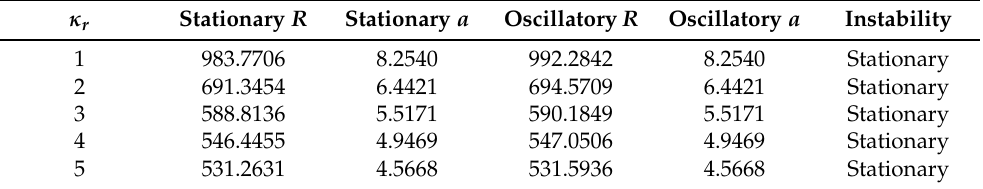
Table 3. Critical stationary and oscillatory Rayleigh numbers for the different values of κ r and the fixed values of S = 0.8, Ta = 50, and Rc =